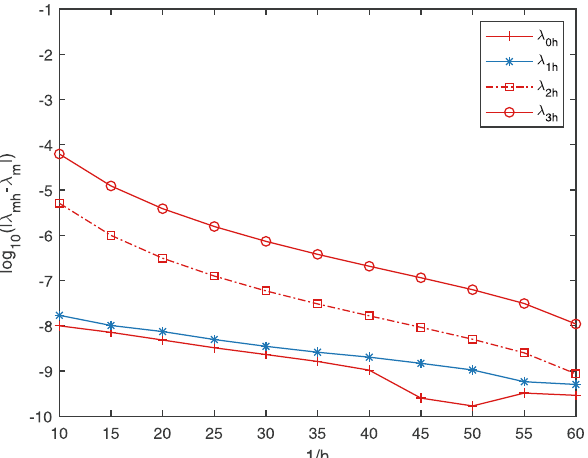
Figure 4: Error curves in semilog scale between the numerical solution and the reference solution for = R 2 .